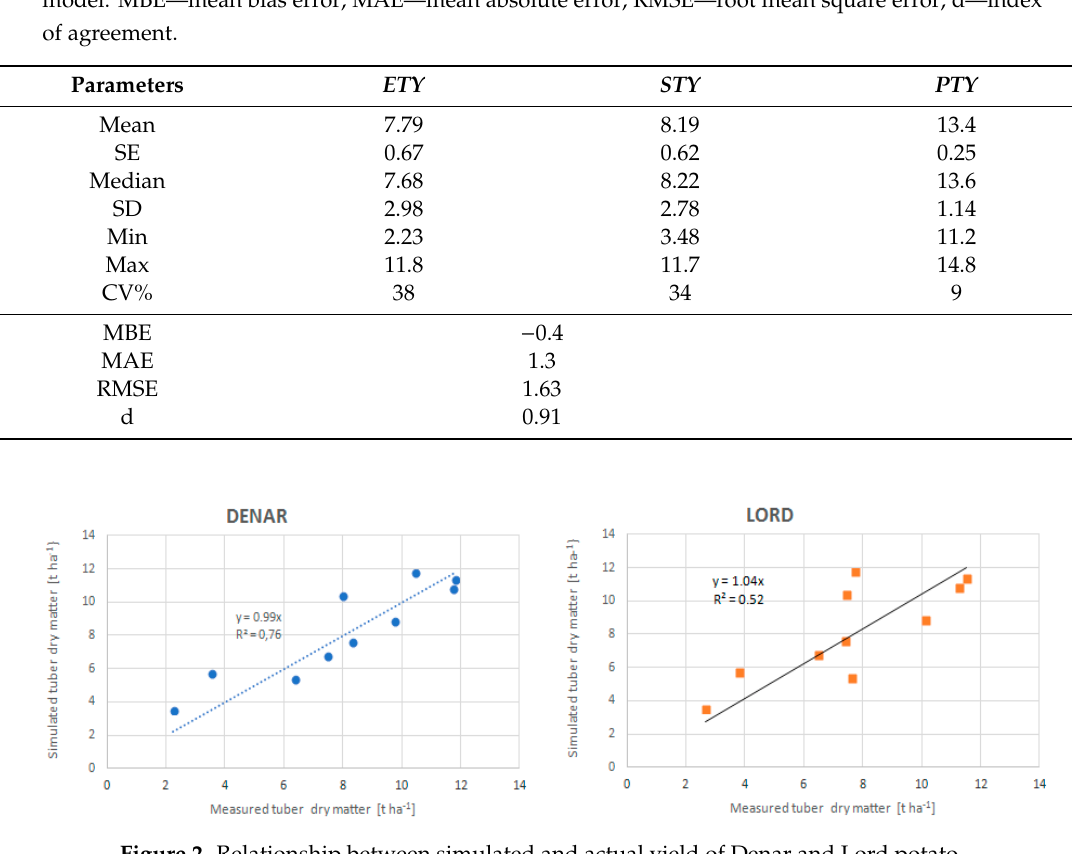
Figure 2. Relationship between simulated and actual yield of Denar and Lord potato.